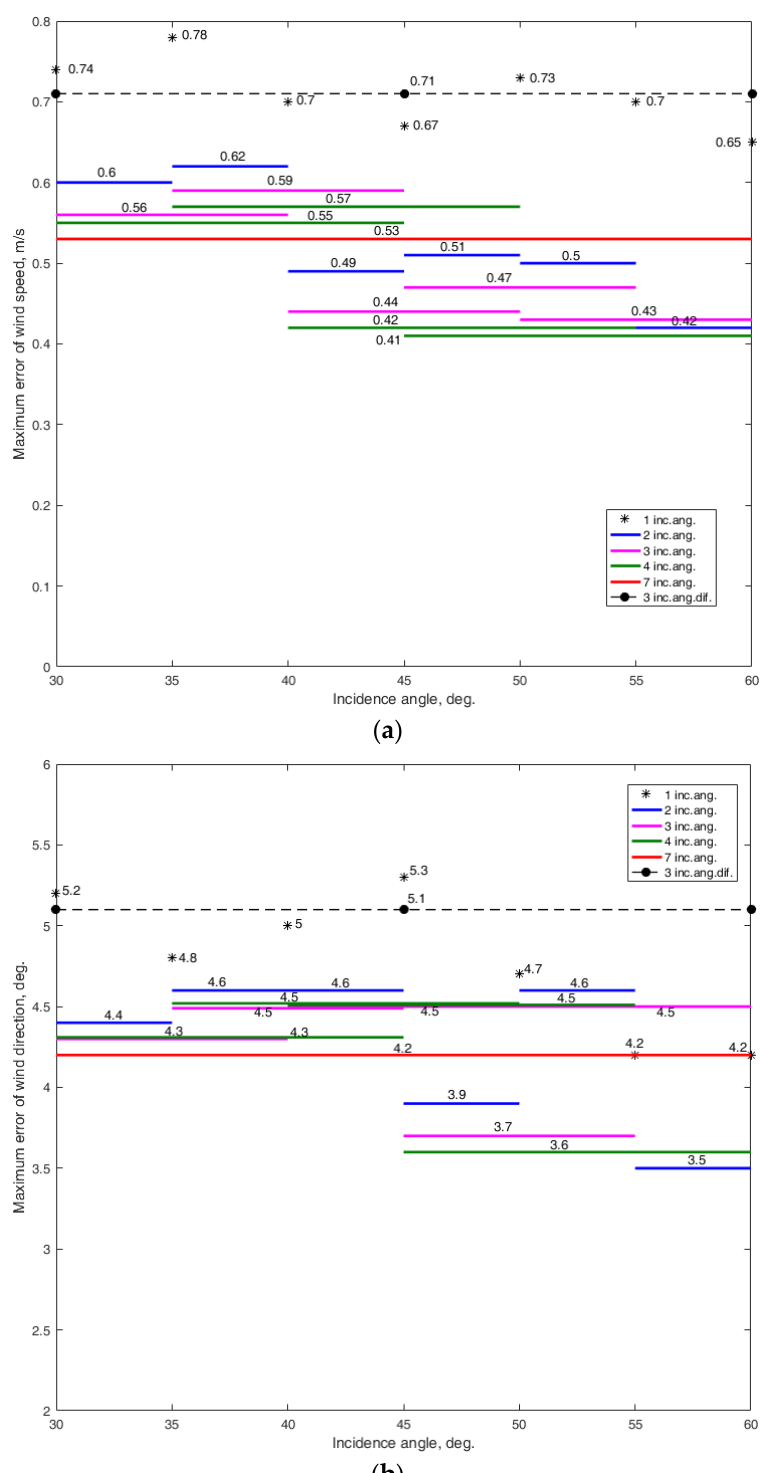
Figure 4. Semicircular NRCS sampling scheme results: ( a ) wind speed maximum error; ( b ) wind direction maximum error. The black asterisks are for the case of a single incidence angle; the blue lines are for the case of 2 incidence angles; the purple lines are for the case of 3 incidence angles; the green lines are for the case of 4 incidence angles; the red line is for the case of 7 incidence angles; and the black, dashed line with dots is for the particular case of 3 incidence angles of 30 ◦ , 45 ◦ , and 60 ◦